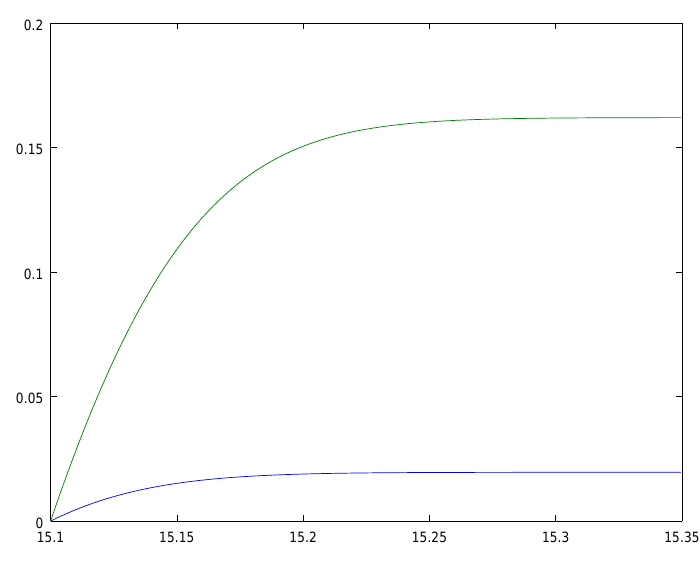
( t ) (blue). 0 (cid:48)